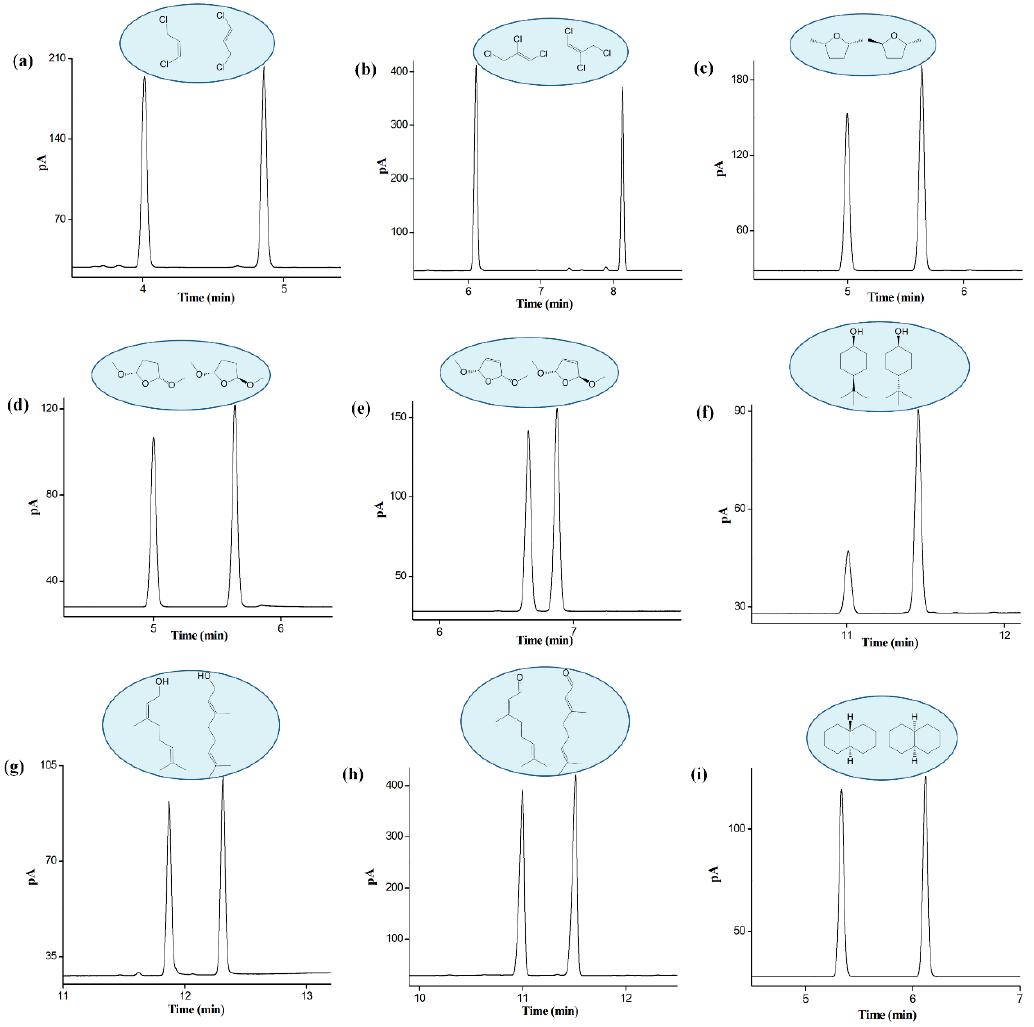
Figure 4. Separation of cis -/ trans -isomers of ( a ) 1,3-dichloropropene, ( b ) 1,2,3-trichloropropene, ( c )2,5-dimethyltetrahydrofuran, ( d )2,5-dimethoxytetrahydrofuran, ( e )2,5-dihydro-2,5-dimethoxyfuran, ( f ) 4- tert -butylcyclohexanol, ( g ) nerol/geraniol, ( h ) citral, and ( i ) decahydronaphthalene on the PCL-PEG-PCL column. Temperature program for all isomer mixtures: 40 °C(1 min) to 160 °C at 10 °C/min, flow rate at 0.6 mL/min.